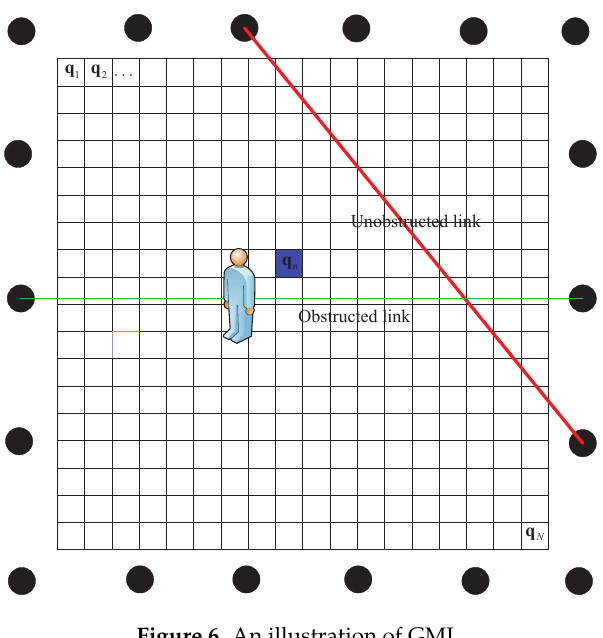
Figure 6. An illustration of